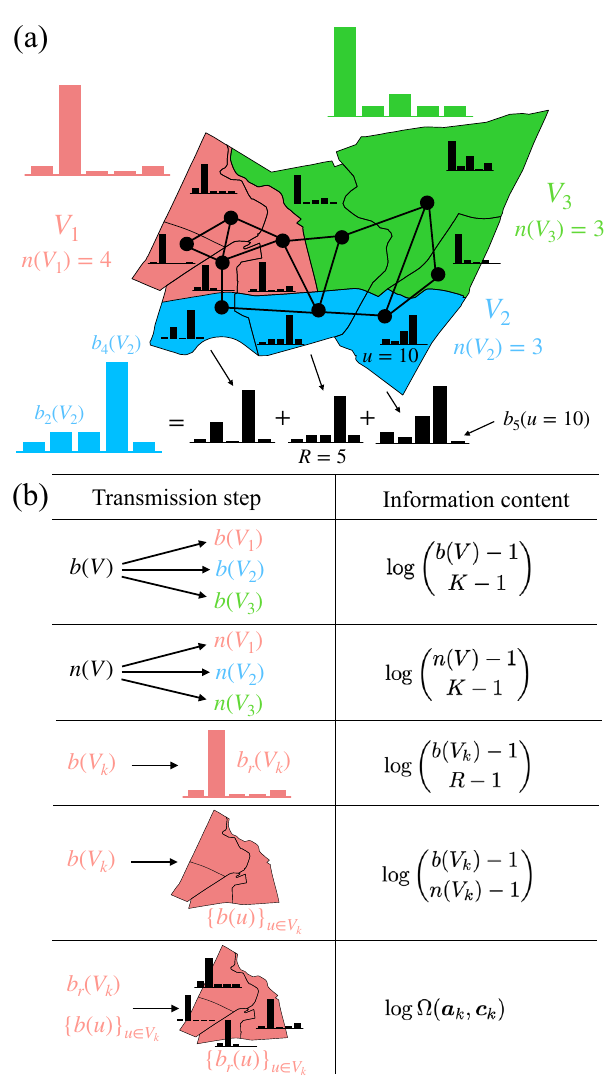
Fig. 4 Diagram of description length formulation. a Variables used in the decription length objective (Eq. (16)), for the partition P of example unit- level distributions that gives the minimum description length according to Eq. (16). The optimal contiguous partition of the underlying network of spatial adjacencies (nodes and edges in black) results in aggregated regions that capture most of the information content of the data. b Individual transmission steps corresponding to each of the fi ve terms in Eq. (16), along with their corresponding information content. Arrows go from coarser objects to more detailed subsets of these objects, which requires the speci fi cation of an amount of information quanti fi ed by the term to the right of the dividing